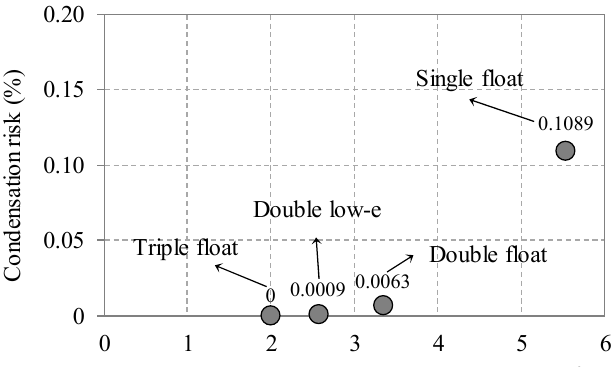
Figure 14. Heat transfer coefficients (U-factors) of windows and condensation risk (thermal insulation of external the wall = 75 mm, thermal insulation of the roof = 105 mm).